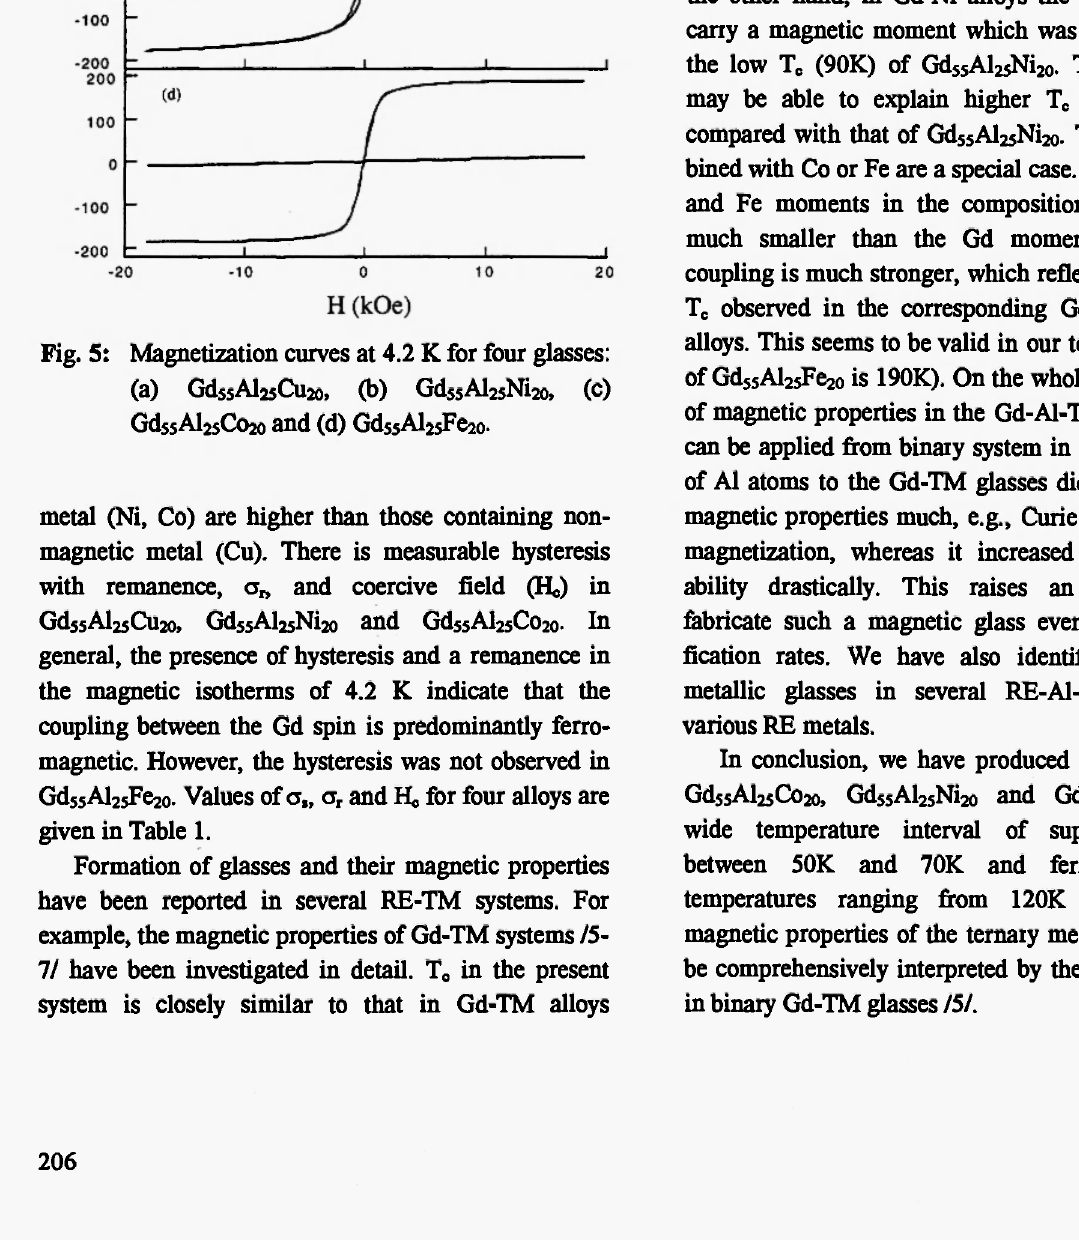
5Al Ni2o, (c) 5 25